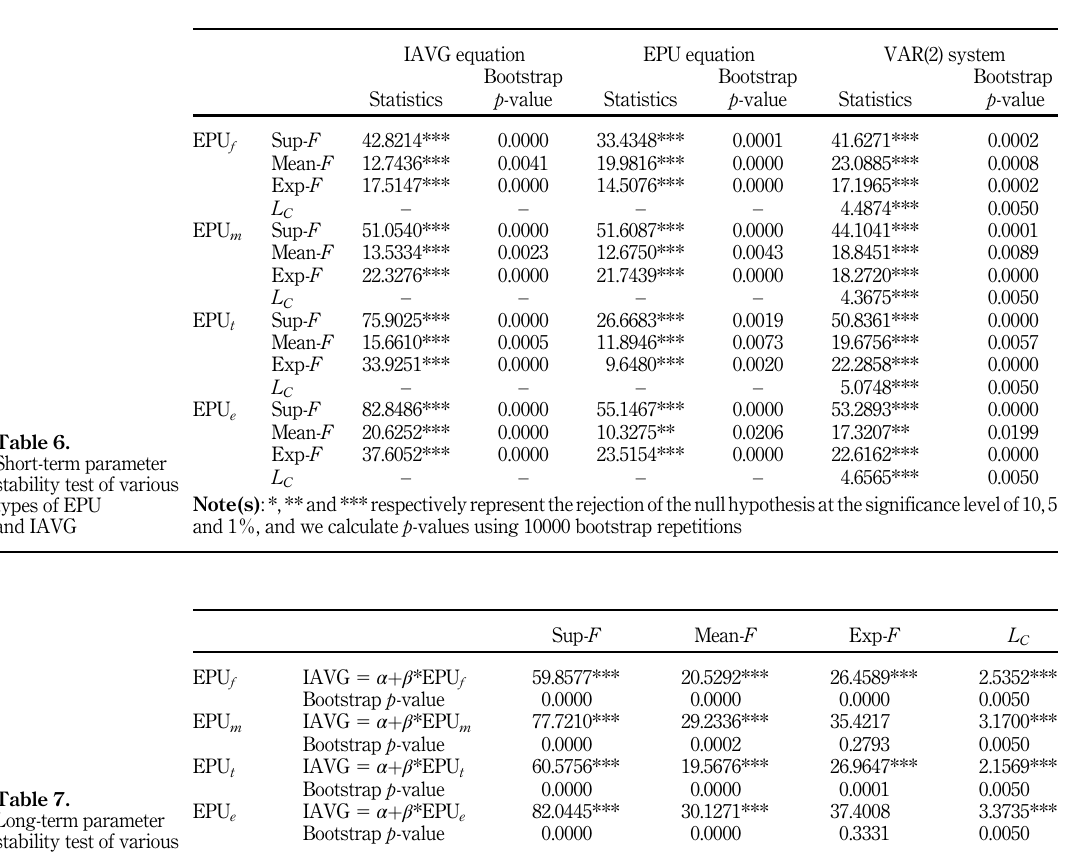
Table 7. Long-term parameter stability test of various types of EPU and